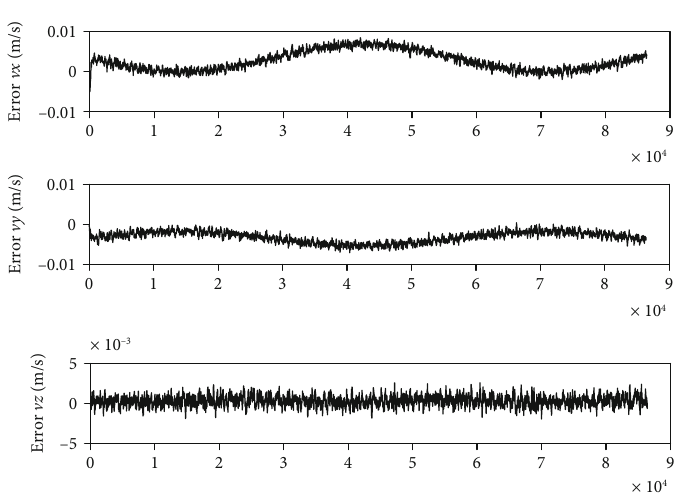
Figure 7: Position estimation error (UKF).